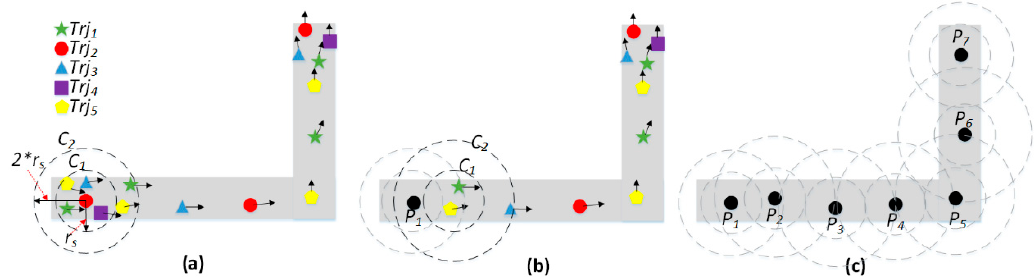
Figure 6. Trajectory cluster resampling. ( a ) Seed selection and window generation. ( b ) Point resampling and window slide. ( c ) Collaborative trajectory generation.